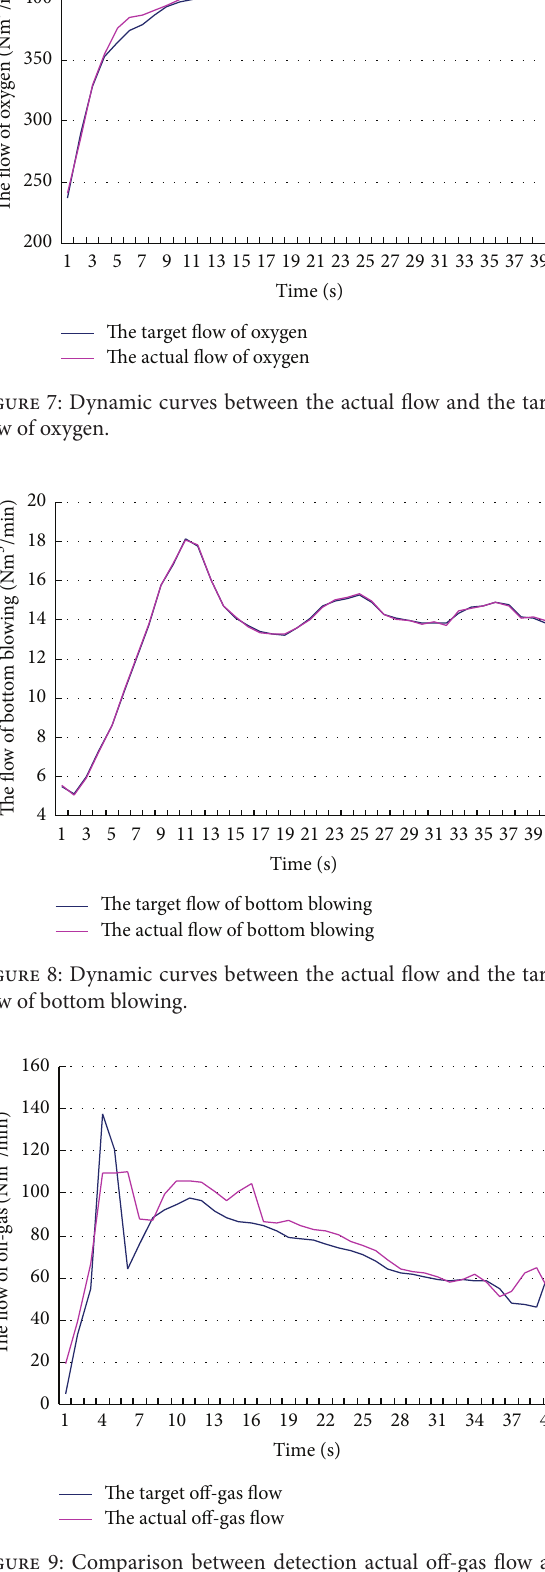
Figure 9: Comparison between detection actual off-gas flow and reference value of off-gas.